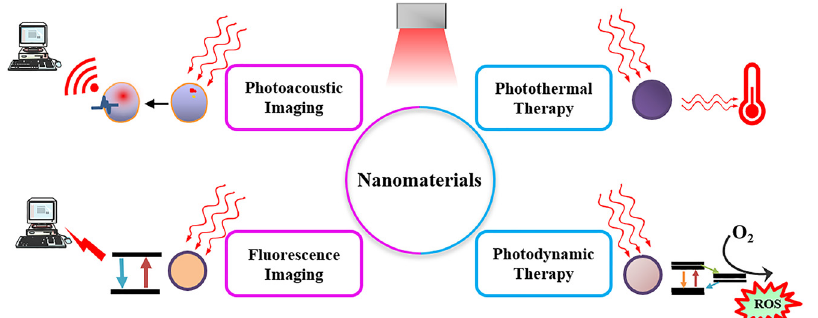
Figure 2: Applications of nanomaterials in photoimaging and